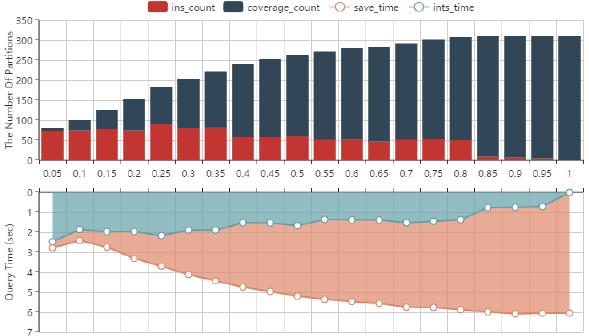
Figure 8. The advantage of Avoiding Intersection Calculation for Fully Covered Regions In the bottom half of Figure 8, the blue curve shows the query time in the case of avoiding polygon intersection calculation for polygon. And the red curve shows the corresponding query time by performing polygon intersection calculation on all